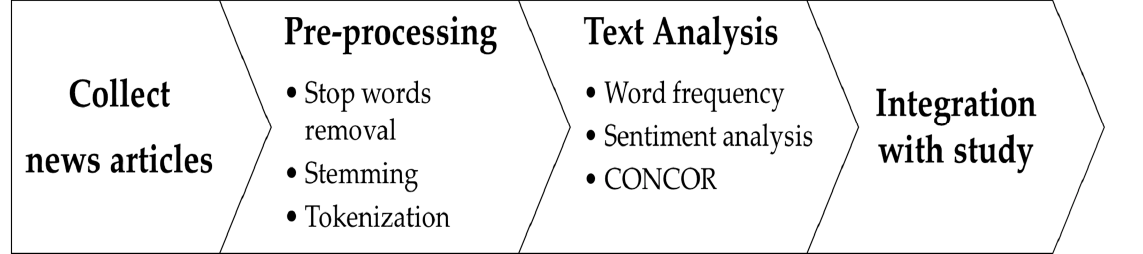
Figure 1. Text mining process .